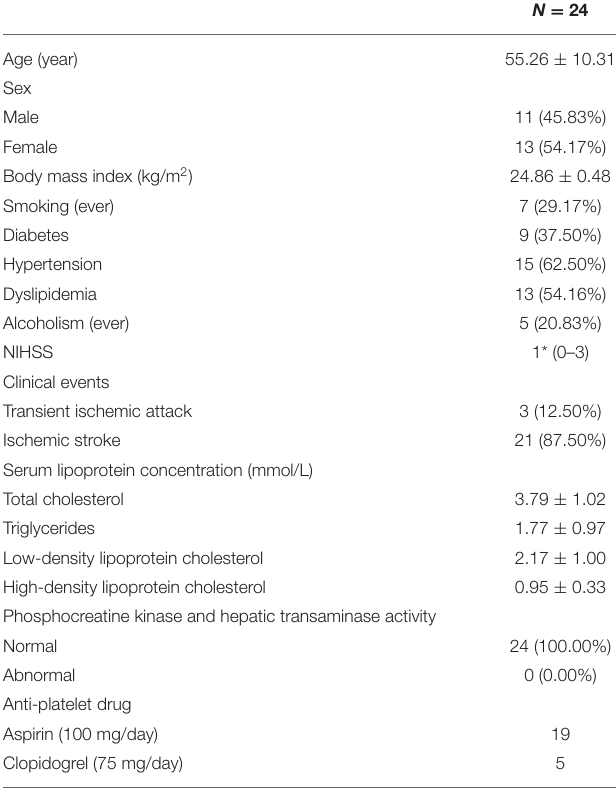
TABLE 2 | Patients’ baseline clinical information.